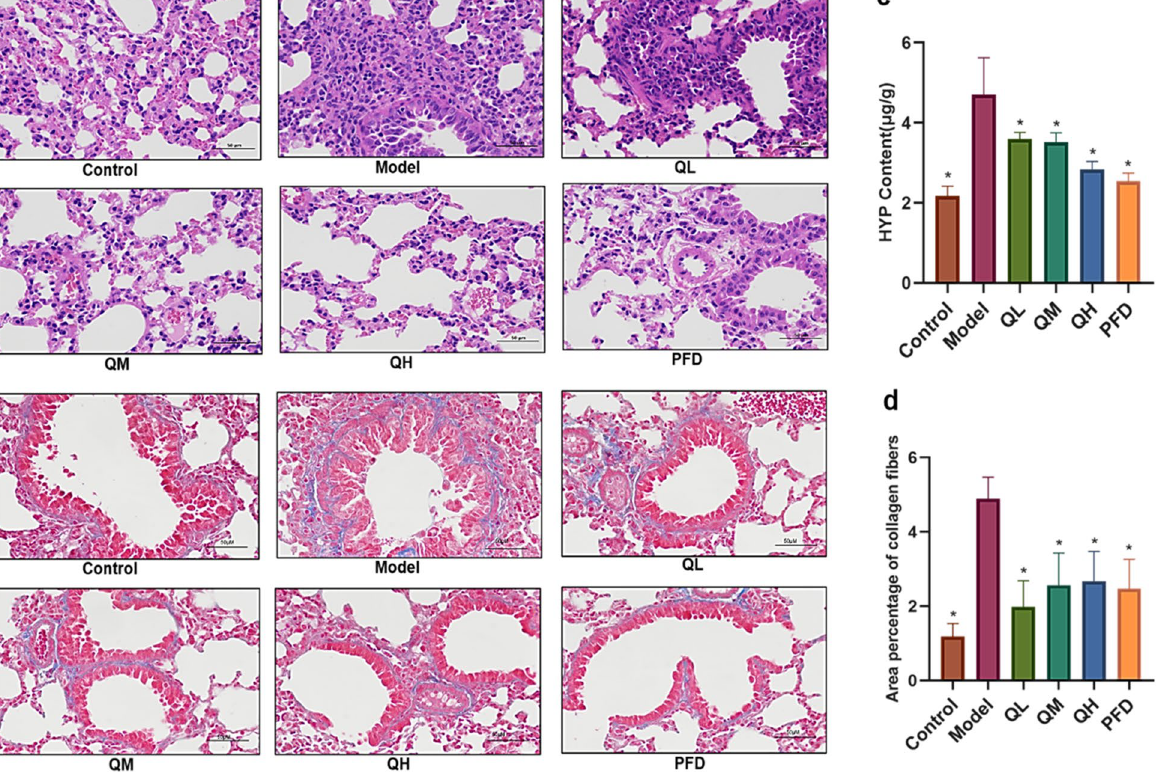
Figure 1. Therapeutic effect of QLT in PF mice. ( a ) HE staining was used to indicate the morphology of pulmonary tissue (400 × magnification). ( b ) Masson staining was used to indicate collagen deposition in pulmonary tissue (400 × magnification). ( c ) The area percentage of blue collagen fibers in Masson pathological sections. ( d ) The level of hydroxyproline in pulmonary tissue. (n = 3; data are expressed as mean ± SD. * P < 0.05, compared with Model